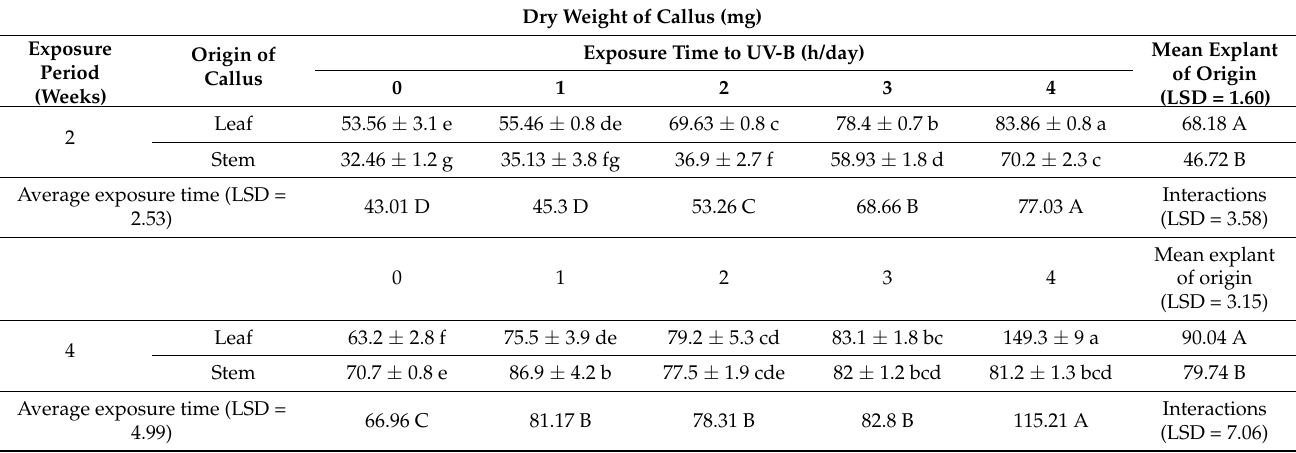
Table 2. Effect of time of exposure to UV-B radiation and origin explant on the dry weight of the callus culture.